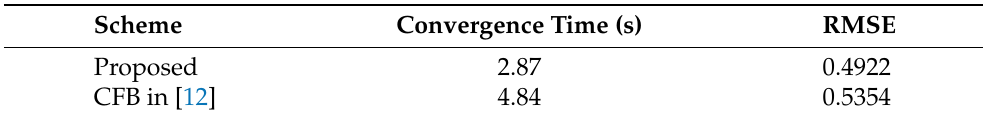
Figure 8. The OTE under different control schemes. Table 2. Performance